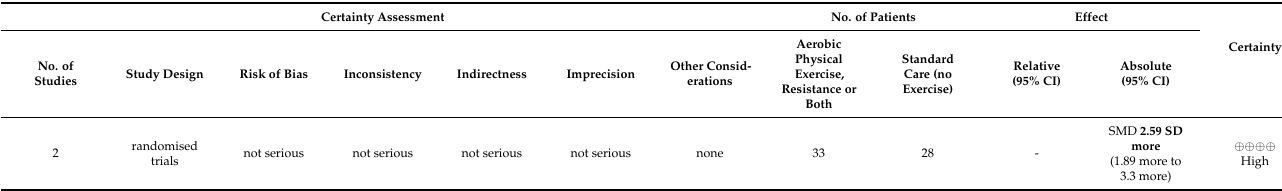
Figure 7. Forest plot of the functional capacity for the 6MWT [17,18]. Table 3. Quality of evidence for the functional capacity of the 6MWT.